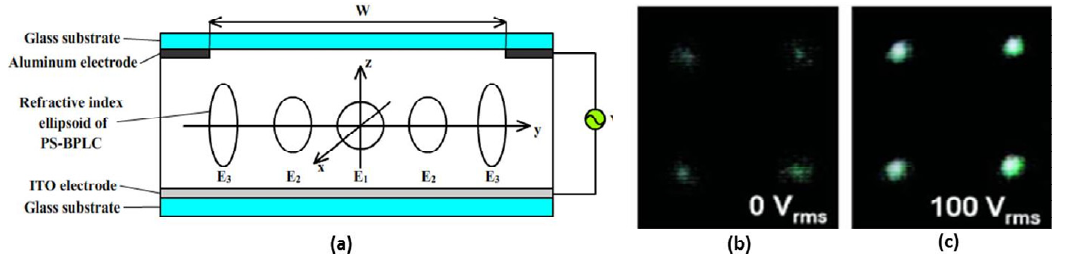
and (c) 100 V rms rms